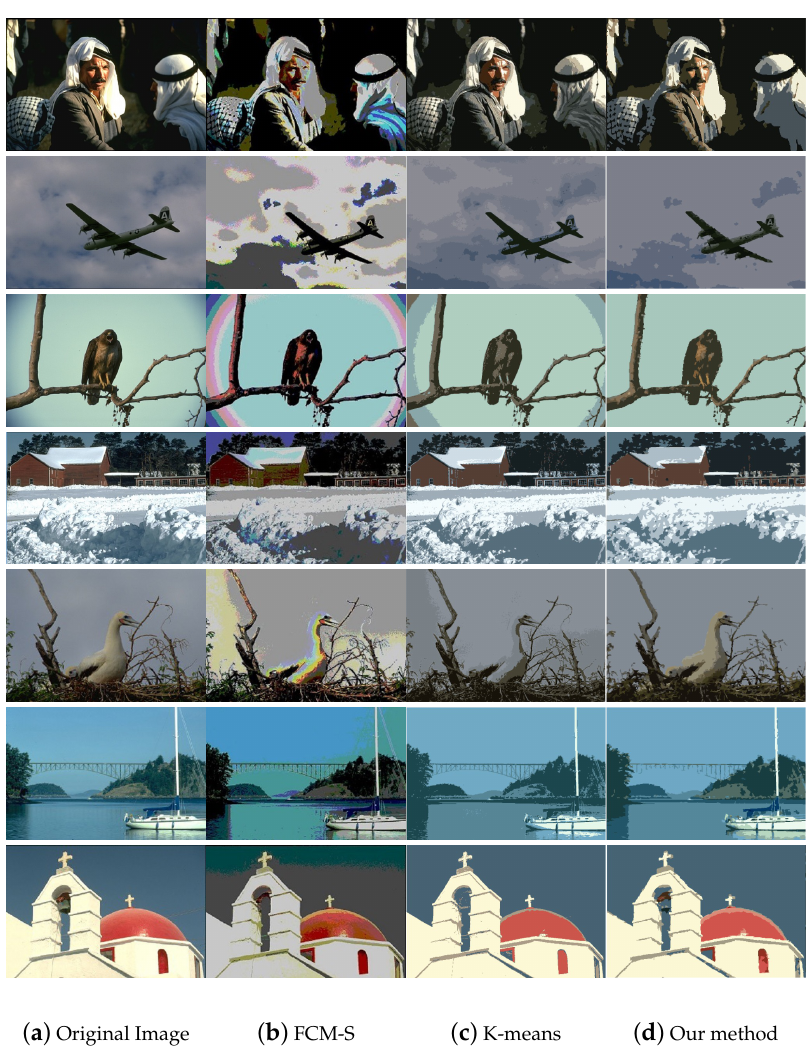
Figure 9. Results for different segmentation algorithms based on clustering. ( a ) Original image ( b ) FCM-S based segmentation ( c ) K-means based segmentation ( d ) The method we